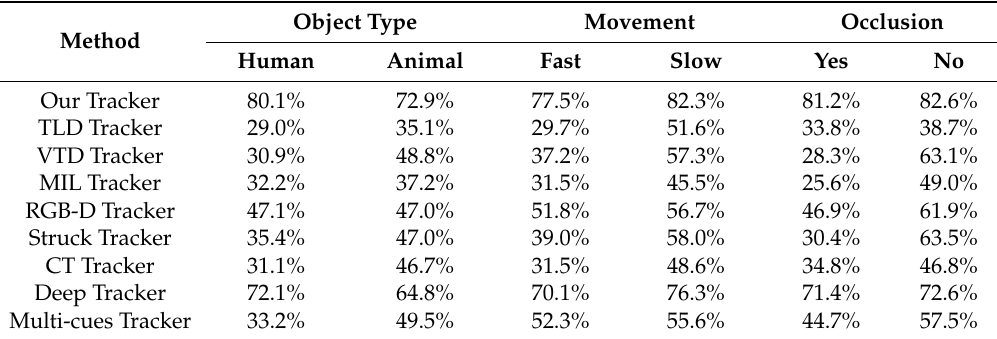
Table 1. The evaluation results of SR under different categorizations.